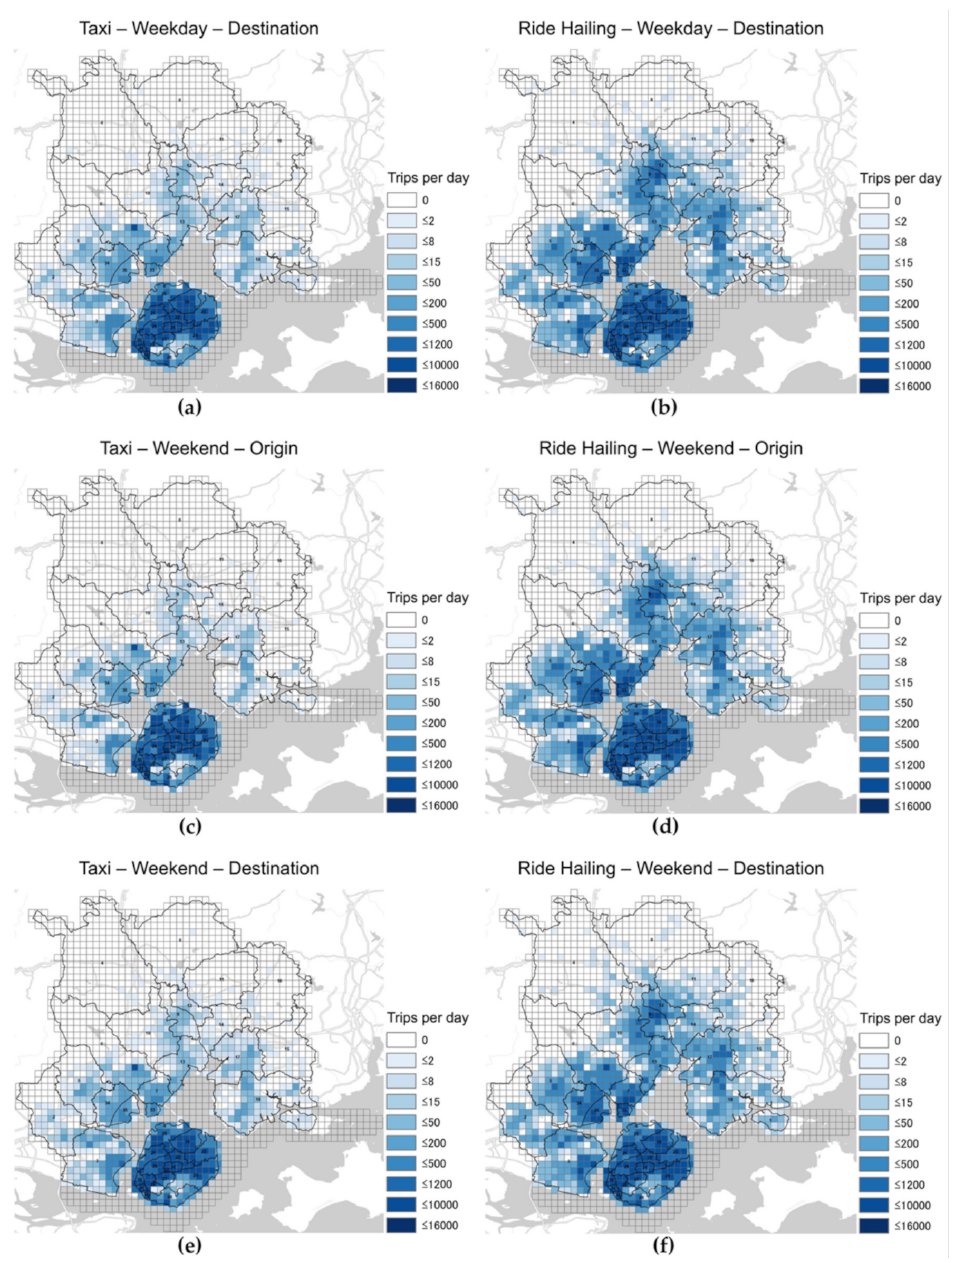
Figure A1. Spatial distribution of average daily trips of taxi and ride-hailing: ( a , b ) incoming trips on weekdays; ( c , d ) outgoing trips at weekends; and ( e , f ) incoming trips at